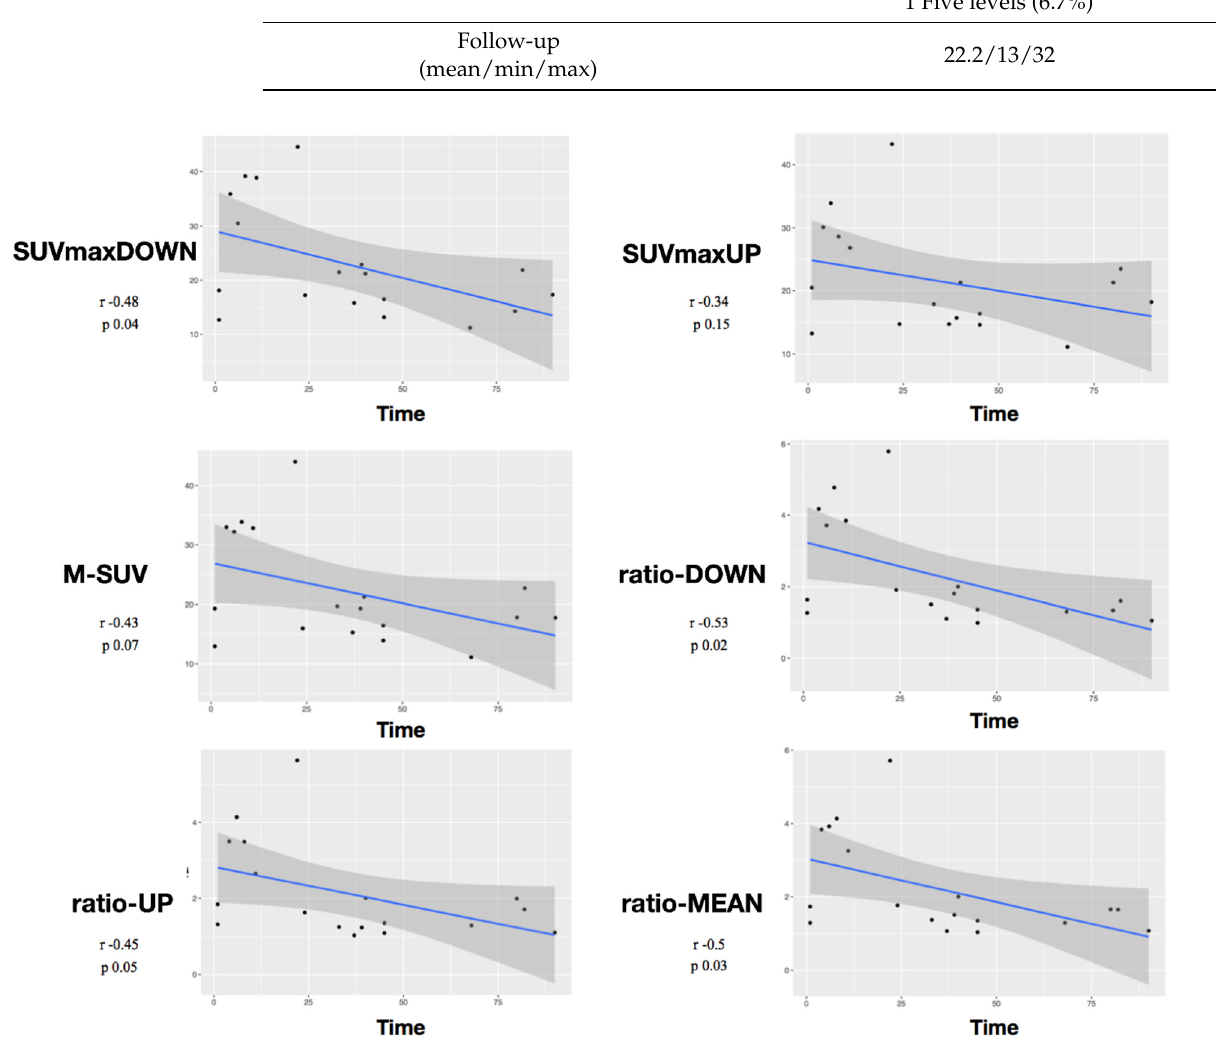
Figure 2. Pearson correlation analysis between all considered variables and time. Scatter plots were drawn to visualize the relationship with a regression line.